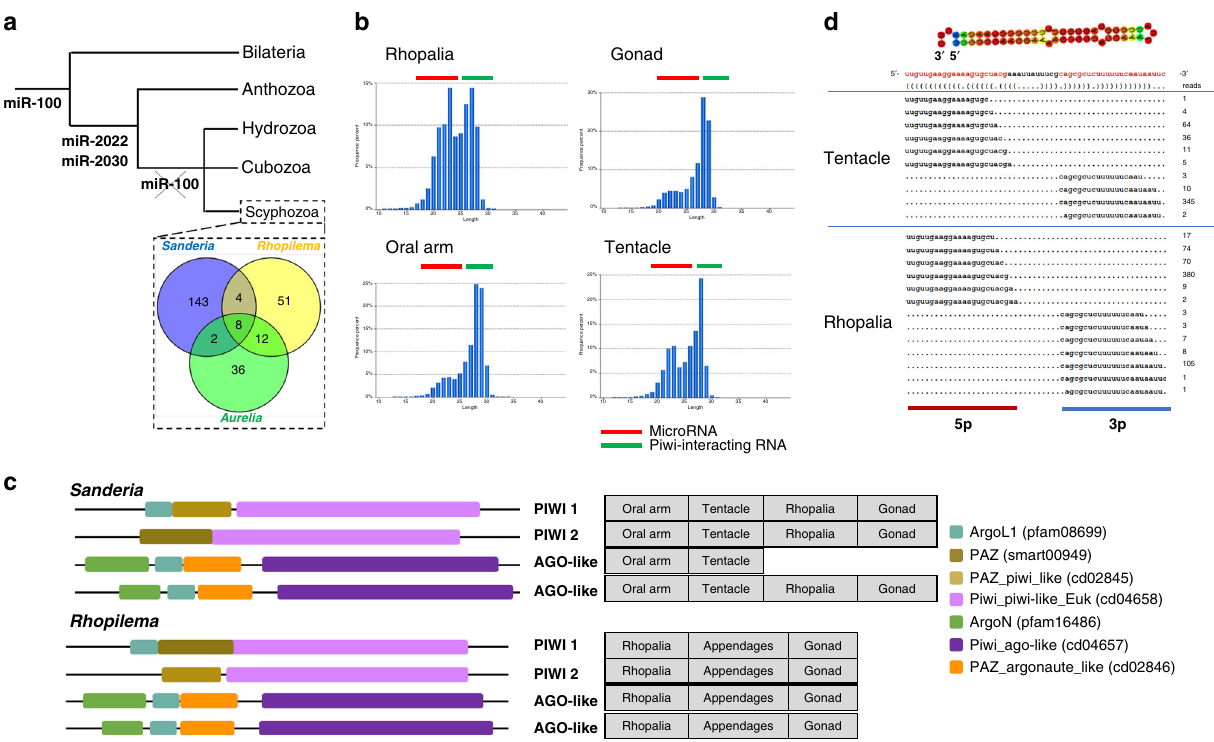
Fig. 5 Small RNAs in jelly fi shes. a Gain and loss of microRNAs in bilaterians and cnidarians. miR-100 has been lost in the medusozoan lineages; b Size distribution of small RNA reads from different tissues of Sanderia malayensis ; the red and green bars indicate putative microRNAs and piwi-interacting RNAs, respectively. The presence of both types of small RNAs in somatic tissues is a widespread cnidarian feature; c Domain organisation of deduced Ago and PIWI proteins in the two jelly fi sh genomes; sequences given in supplementary information 1; d An example of microRNA in Sanderia malayensis displaying differential arm usage in different tissues demonstrating microRNA arm switching in